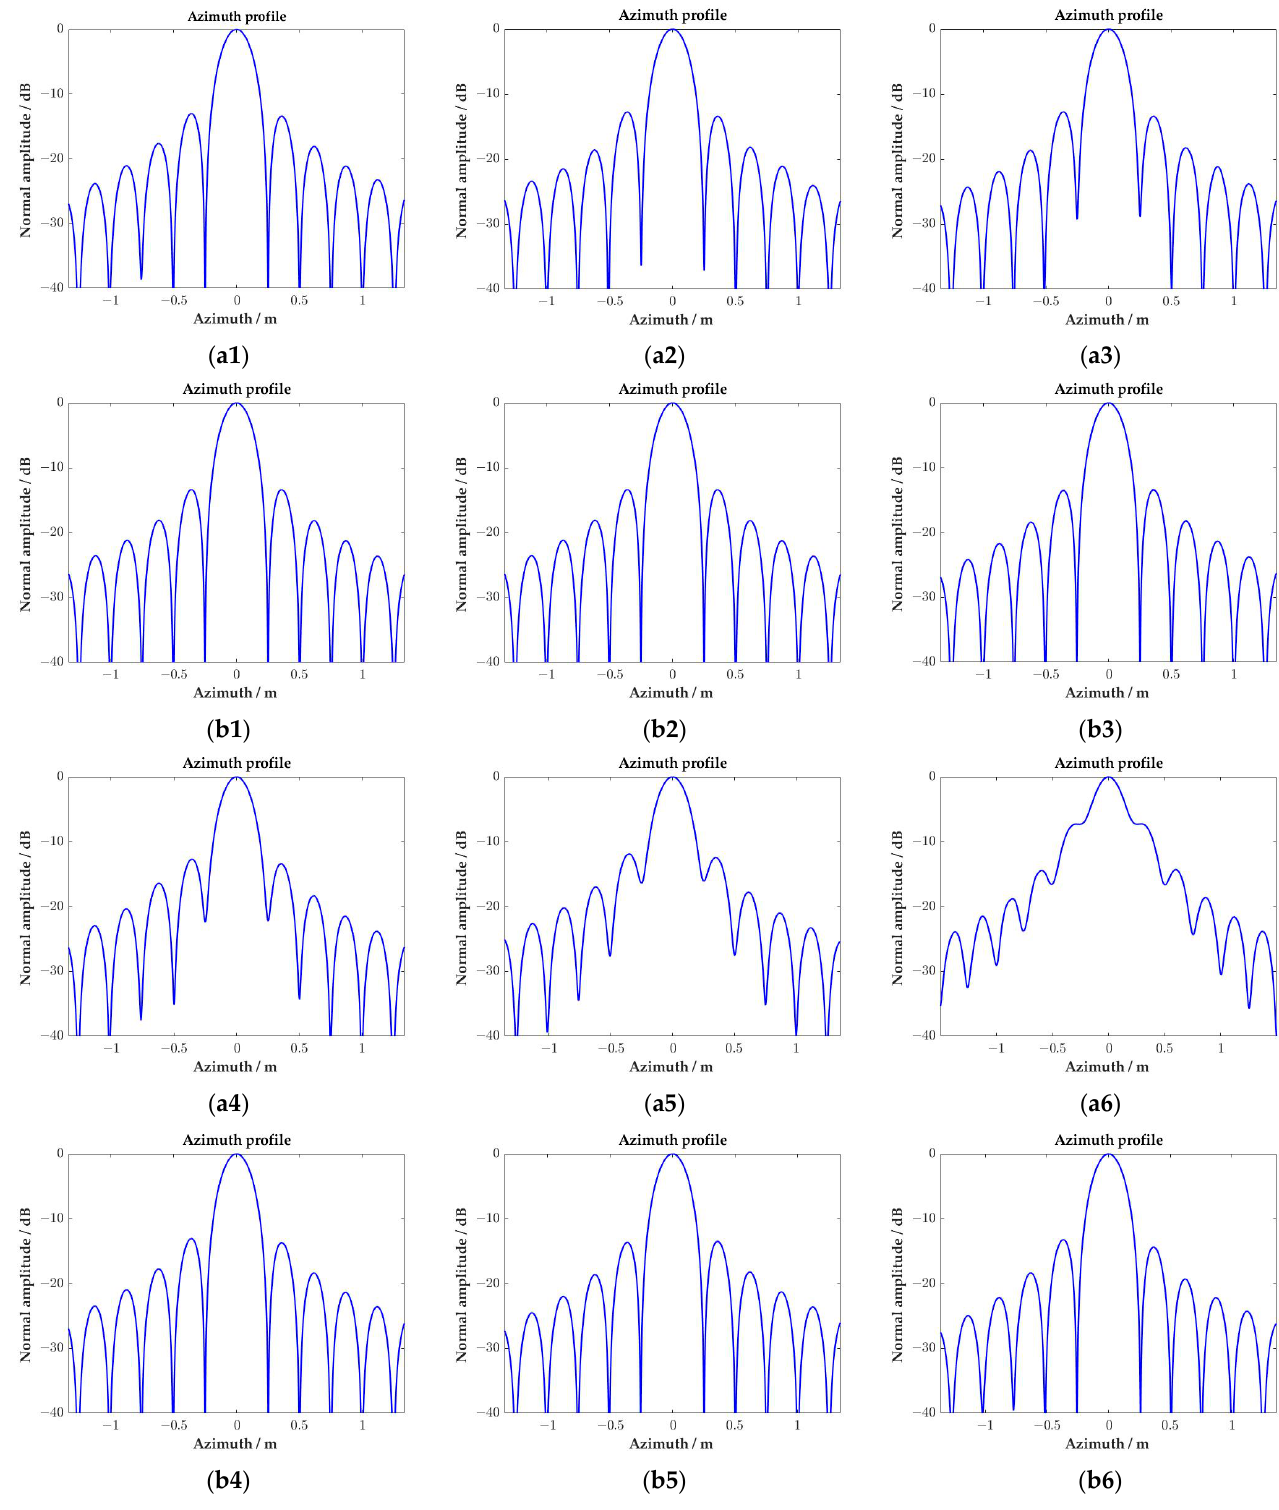
Figure 9. Evaluated results of azimuth profile for the chosen targets corresponding to 0.25 m azimuth resolution. ( a1 – a6 ) The results of Targets 17–22 before the Doppler phase perturbation. ( b1 – b6 ) The results of Targets 17–22 after the Doppler phase perturbation. All of the results have been up-sampled by 32× to better illustrate the details.